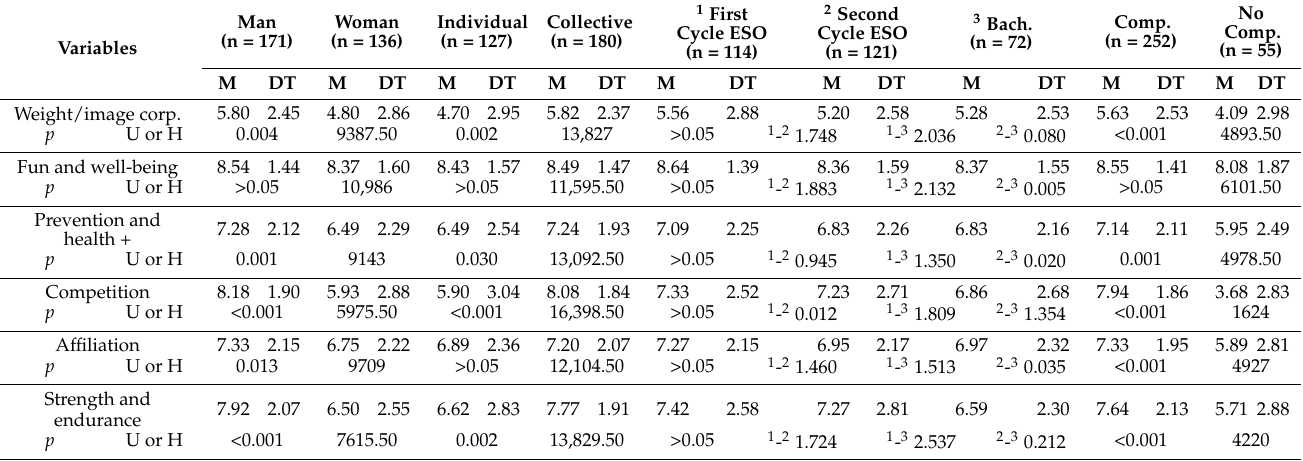
Table 1. Relationship between the factors of the AMPEF questionnaire and socio-sporting